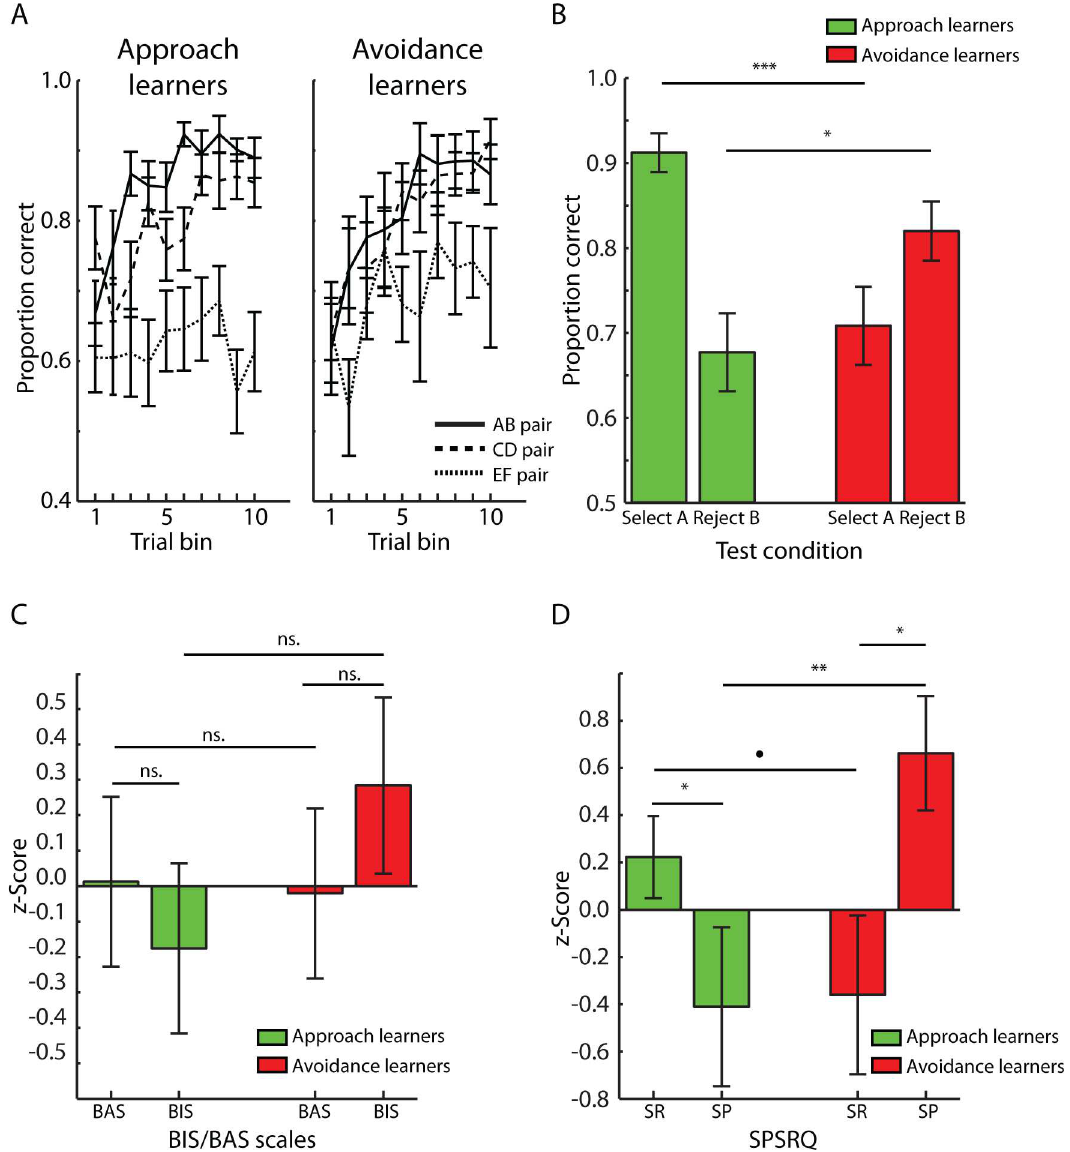
Fig 2. Behavioural data (Mean ± SEM). A. Performance as a function of training. Performance improvedequallyfor participants in the different groups as trainingprogressed. B. Approach and avoidanceperformanceduringtesting. Approach learnerswere relatively better at selectingthe A symbol, as comparedto rejectingthe B symbol, while avoidance learnersdisplayedthe reverse trend. Importantly, this interactionsimply reflects the assignment of participants to different groups basedon their relative performance on selectingthe A-rejectingthe B symbol. However, approach learnerswere also better at selectingthe A symbol as comparedto avoidance learners, whilethe B symbol was more frequently rejected by avoidancelearners. C. Approachand avoidance learnersdid not differ in BAS nor BIS scores. D. Approach and avoidancelearnersscored higheron rewardsensitivity (SR) and punishment sensitivity (SP), respectively. BAS = behaviouralactivationsystem, BIS = behaviouralinhibitionsystem, SP = sensitivity to punishment, SR = sensitivity to reward, SPSRQ = Sensitivity to Punishment and Sensitivity to RewardQuestionnaire. • p < 0.10, * p < 0.05, ** p < 0.01, *** p < 0.001, ns. = not significant(p >